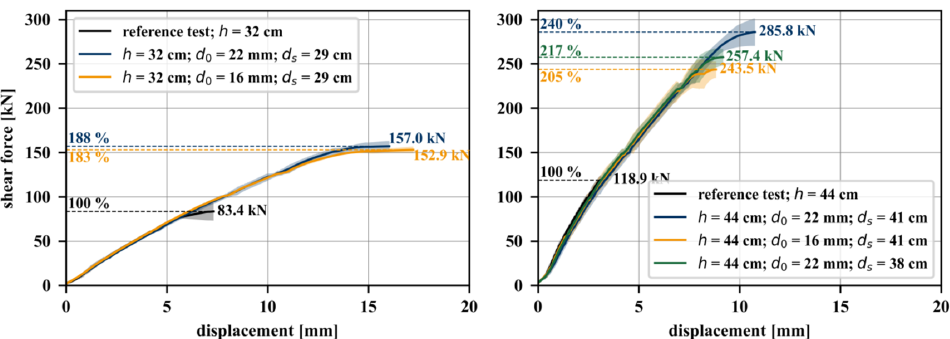
Figure 3. Test results of concrete test girders with heights of 320 mm and 440 mm and with concrete screws of di ff erent diameters d 0 (22 mm and 16 mm) and di ff erent installation depth d s